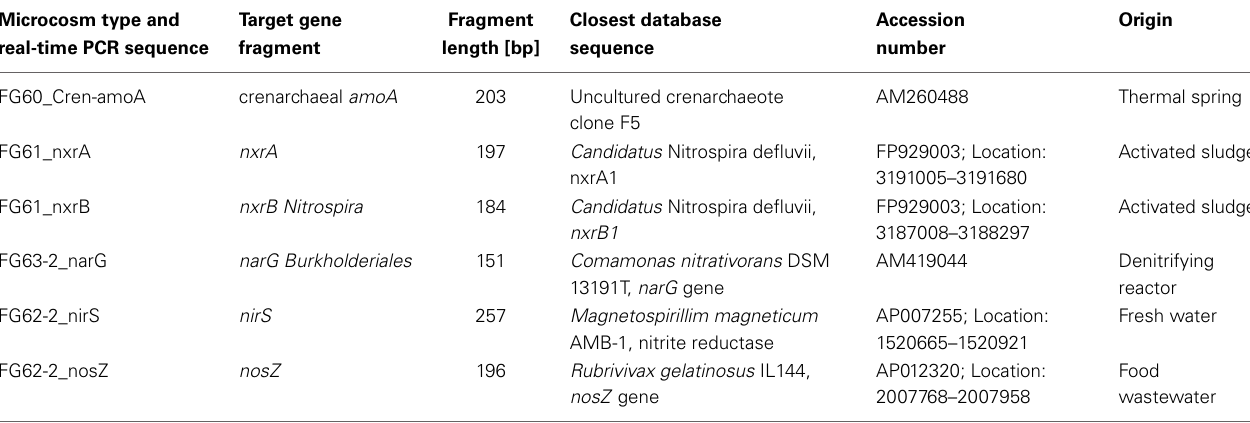
Table 3 | Nearest database sequences of N-metabolizing gene sequences obtained by real-time PCR. Microcosm type and